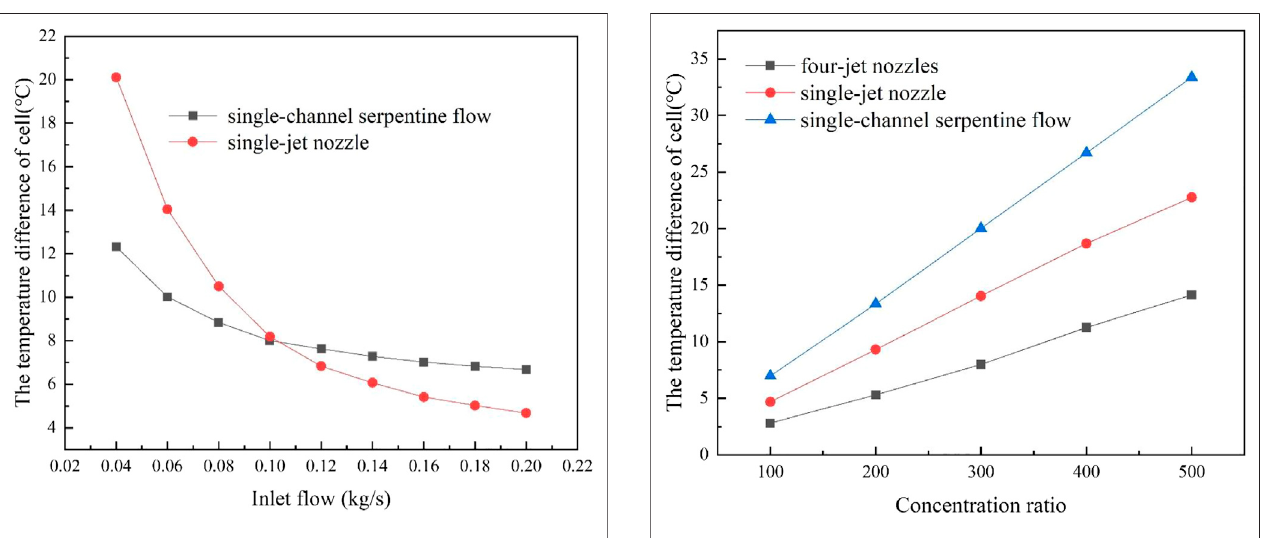
FIGURE 8 | In fl uence of inlet fl ow on the temperature uniformity of the cell.